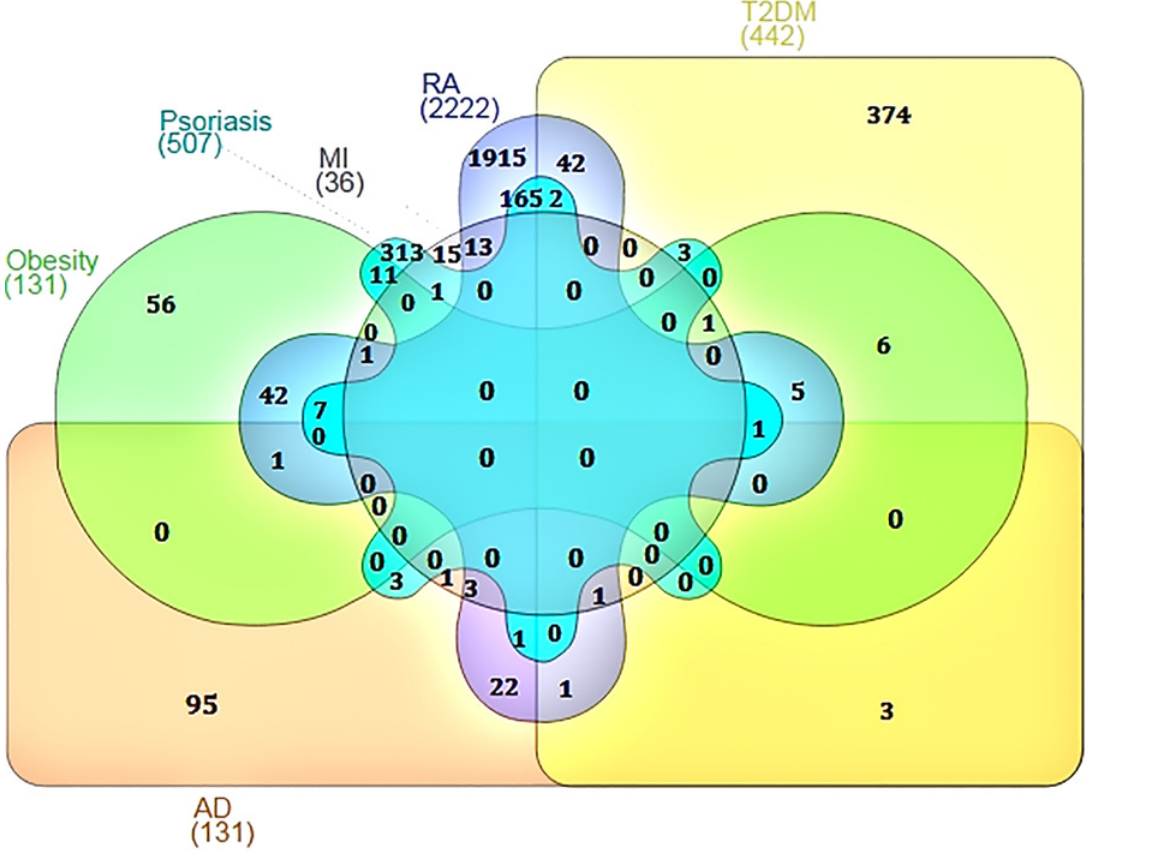
Fig 1. Venn diagram showing the number of overlapping genes between psoriasis and its